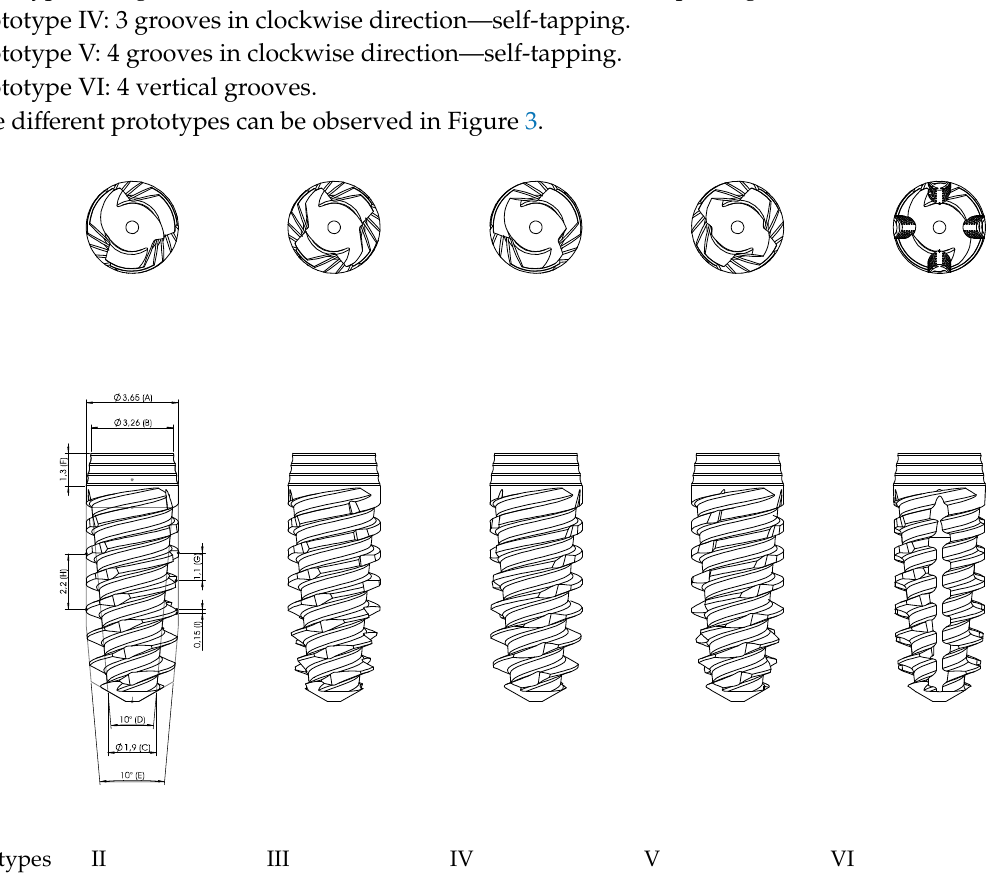
Figure 2. Control design and Prototype I with a more conical core, increased thickness of threads, and the introduction of helicoidal grooves. 2nd Group: Control vs Prototypes II, III, IV, V, and VI.